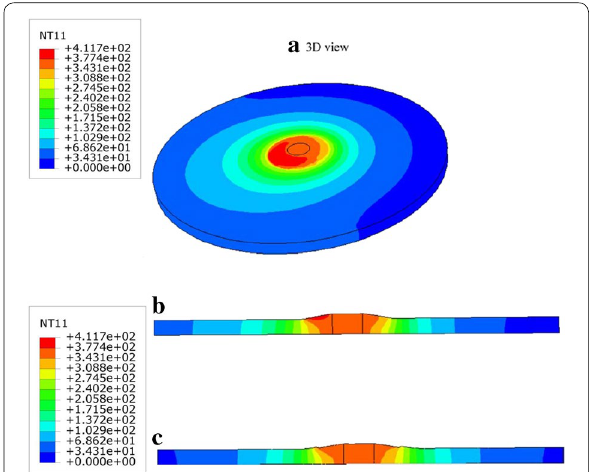
Figure 10 The contour of the peak temperature during the welding: ( a ) the 3D view point, ( b ) the longitudinal direction, and ( c ) the transverse direction